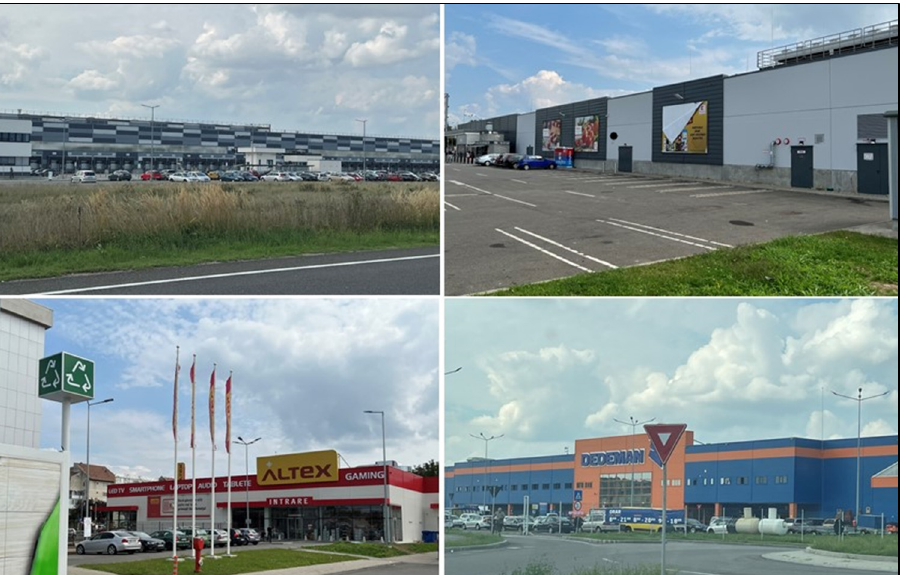
Figure 6. New investments in commercial, retail and logistic sectors developed in the northern industrial area: Lidl, Kaufland, Altex and Dedeman (photos taken by the author, July 2022).